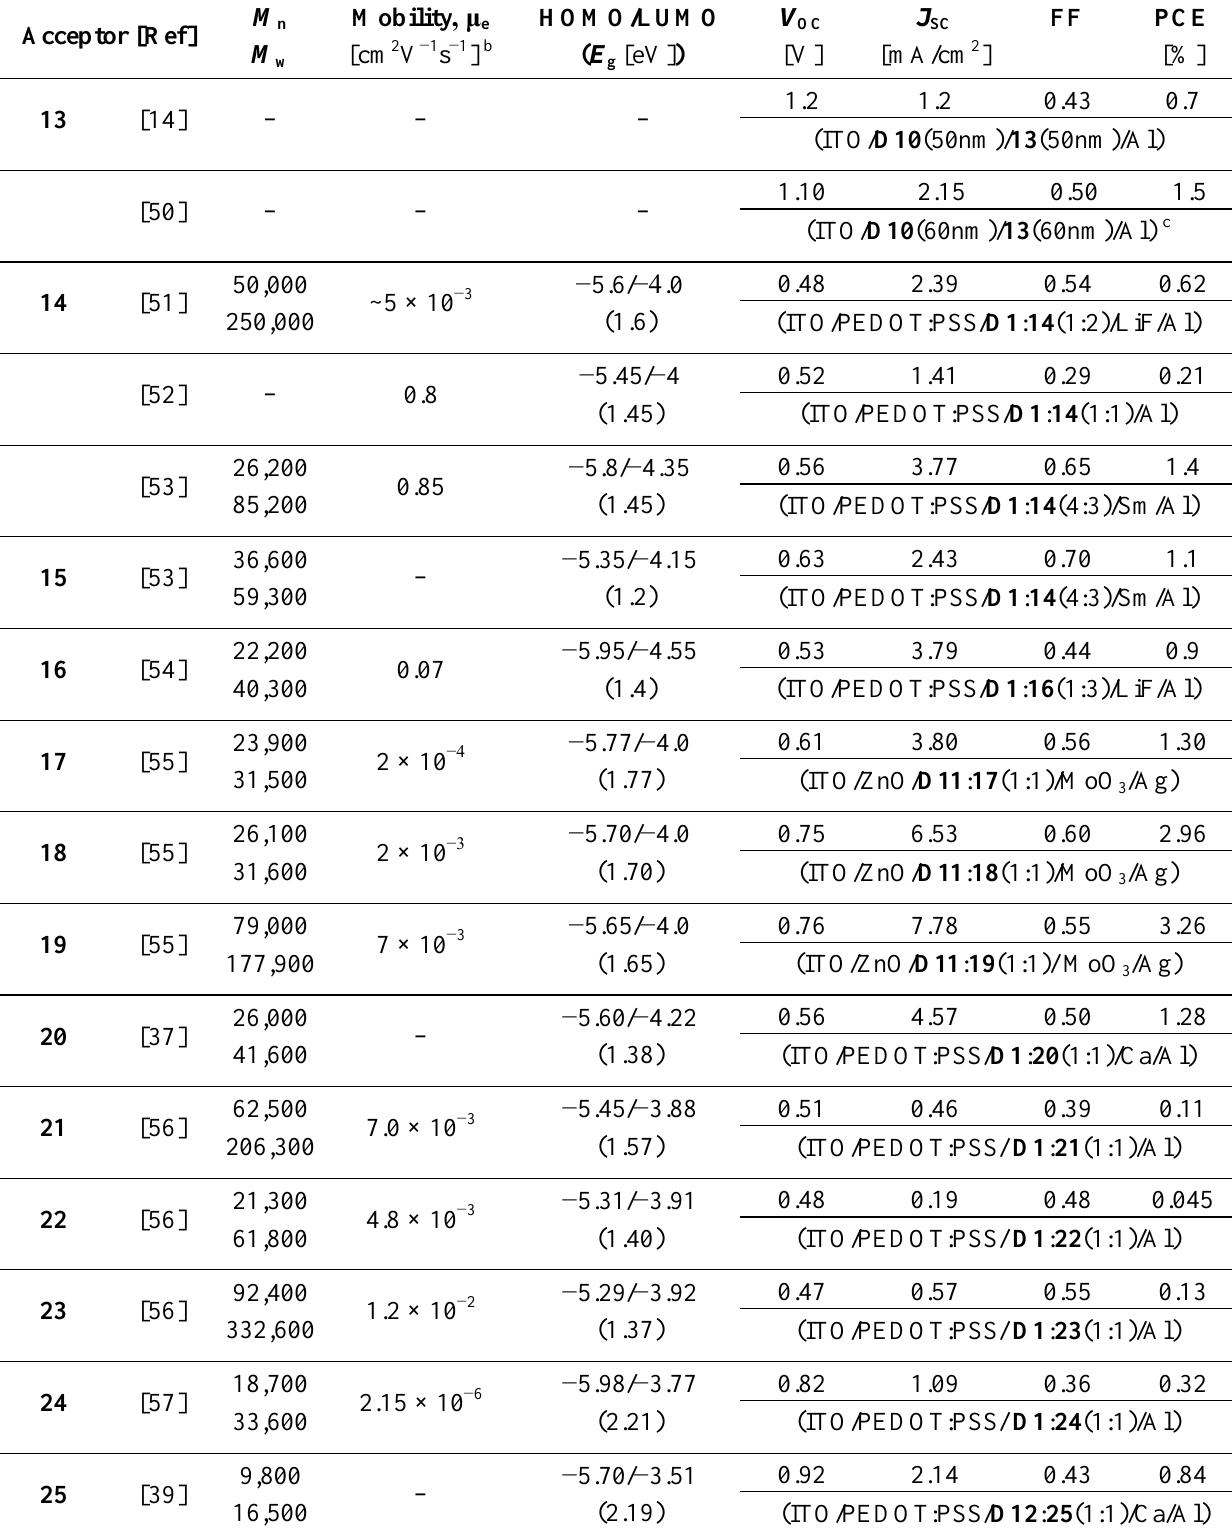
Table 2. Naphthalene diimide (NDI)- and dithienocoronene diimide (DTCDI)-based polymer acceptors a